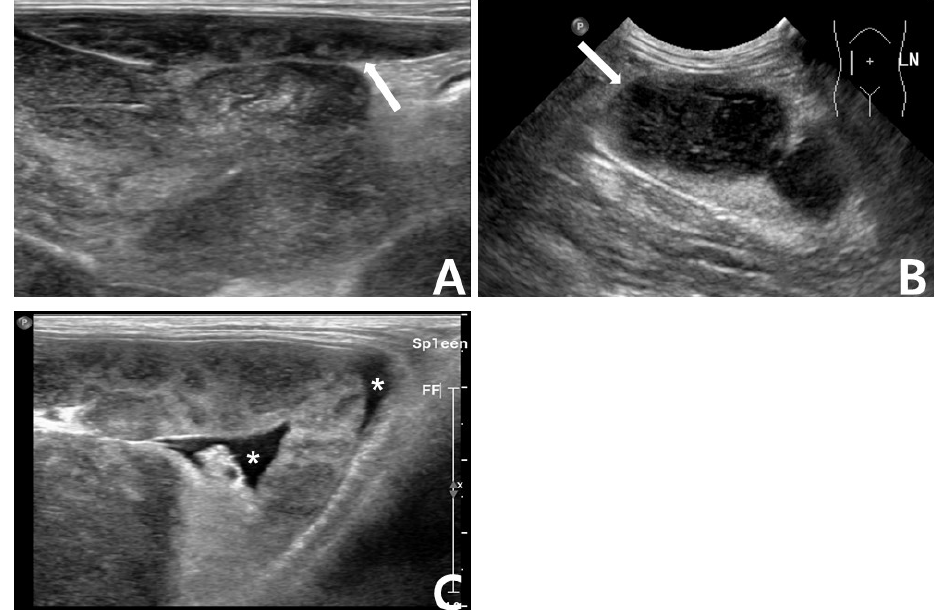
Figure 2. Abdominal ultrasonography. ( A ) Honeycomb-like lesion of splenic parenchyma. The ar- row indicates the spleen. ( B ) Enlarged mesenteric lymph nodes. The arrow indicates enlarged lymph nodes. ( C ) Ascites around the spleen. The asterisks indicate ascites around the spleen. The serosanguineous ascites were identified as exudates (total nucleated cell count: 148,300 cells/µL and total protein: 4.1 g/dL) using CBC and a refractometer, and cytology revealed predominant lymphoid cells, consistent with the features of neoplastic effusion (Figure 3).